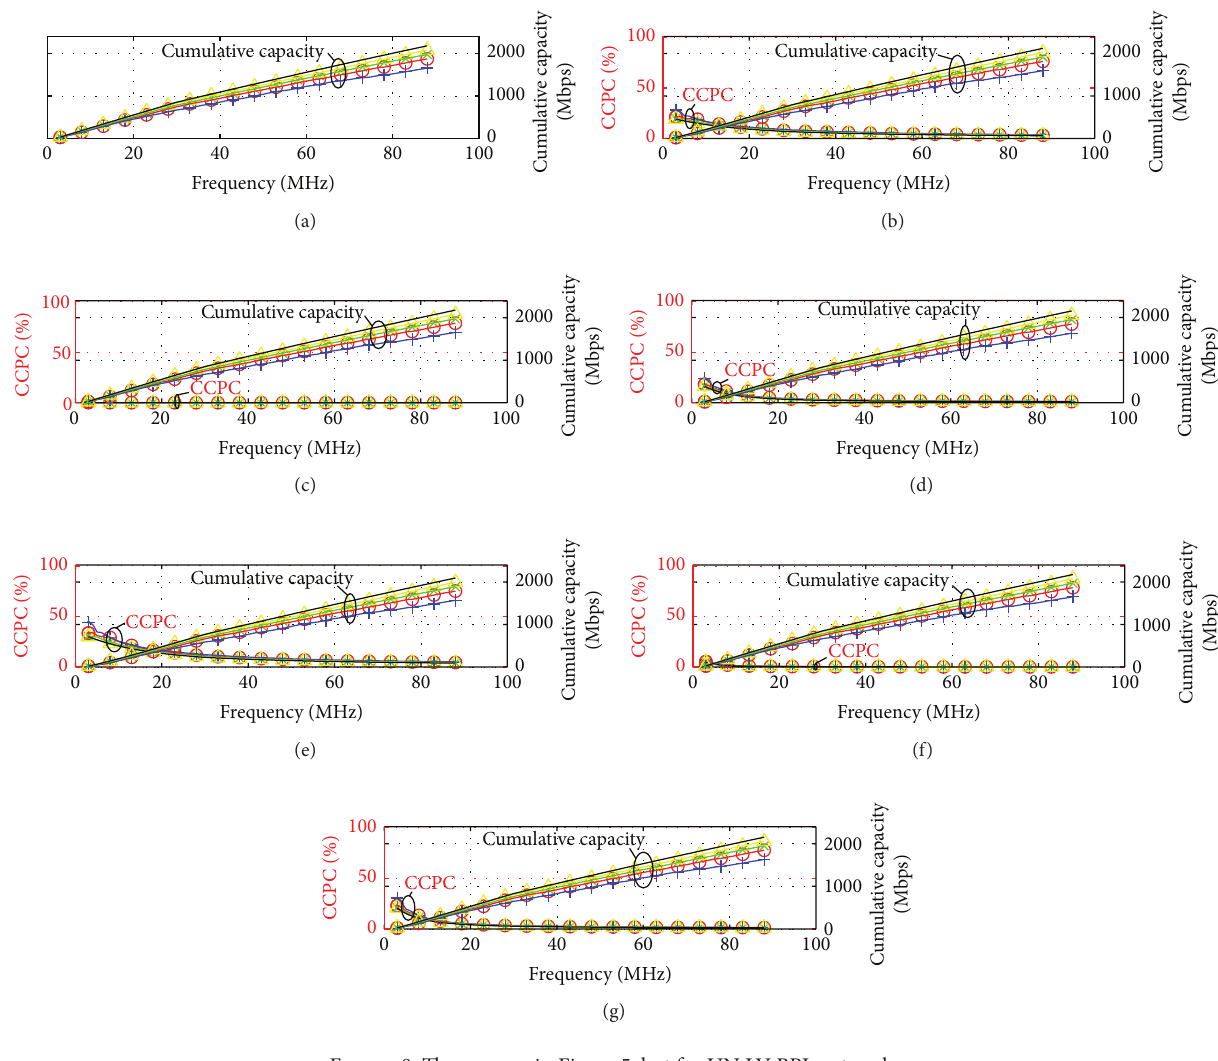
Figure 8: The same as in Figure 5, but for UN LV BPL networks.